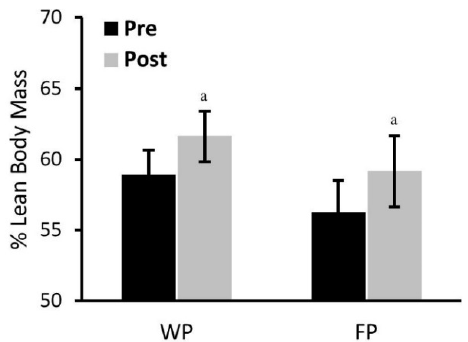
Figure 3. Comparison of percent lean body mass percent (%) lean body mass between the food protein (FP) and the whey protein (WP) groups following the PRISE training. a Significantly different from baseline in each group ( p < 0.01).